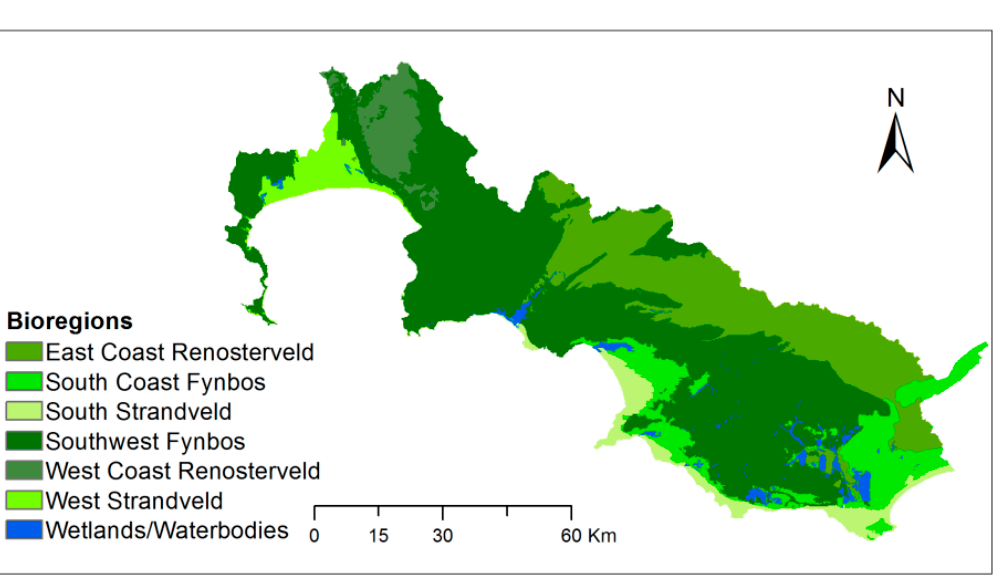
Figure 2. The 2006 natural vegetation map for the study region [33].